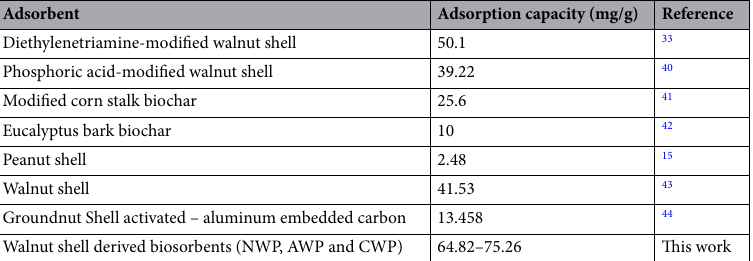
Table 2. A comparative account of adsorption capacities of walnut shell derived biosorbents with other biosorbents.